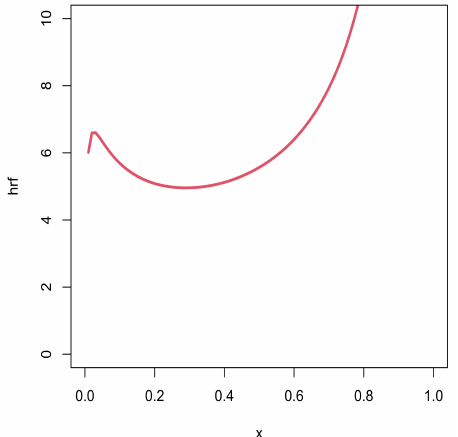
Figure 12. Plots of the estimated hrfs for the failure times data